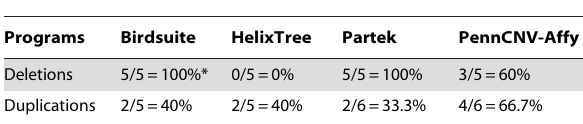
Table 6. Positive predictive value for rare CNVs of each program, based on qPCR validation of their program-specific